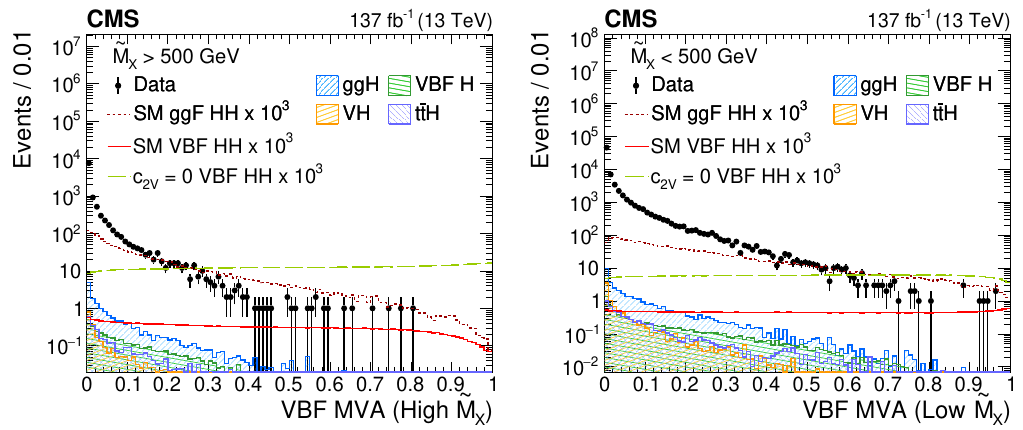
Figure 6 . The distribution of the two MVA outputs is shown in data and simulated events in the two VBF f M regions: f M > 500 GeV (left) and f M < 500 GeV (right). Data, dominated by the X X X γγ + jets and γ + jets backgrounds, are compared to the VBF HH signal samples with SM couplings and c = 0 , SM ggF HH and single H samples ( ttH , ggH , VBF H , VH ) after imposing the 2V VBF selection criteria described in section 5. The error bars on the data points indicate statistical uncertainties. The HH signal has been scaled by a factor of 10 3 for display